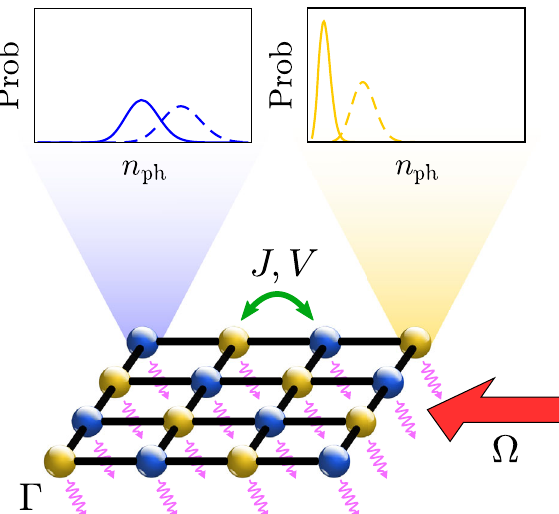
FIG. 1. Schematic illustration of the physical setup. The contrast of the two checkerboard (light yellow and dark blue) sublattices defines the antiferromagnetic order parameter. On each sublattice, there is a low-population (low n ; solid curve) ph and a high-population (high n ; dashed curve) steady state, ph corresponding to the bistability order parameter. The large arrow indicates the drive, while the wavy arrows represent the dissipation. J and V denote the hopping and nearest-neighbor interactions,